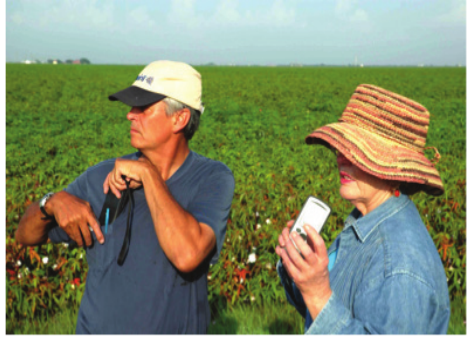
Figure 5. Douglas Crebs, Stone Child College, and Barbara Du- Frain, Delmar College, learn how to use a Global Positioning Sys- tem (GPS). Crebs commented, “The training that was provided... was fantastic. One of the most professional and rigorous trainings I have been involved